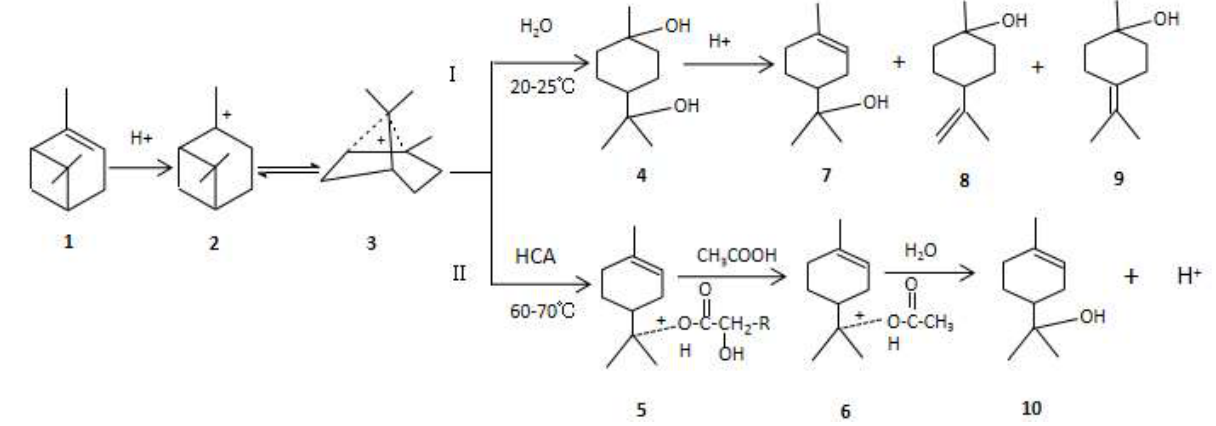
Figure 7. Hydration of α-pinene catalyzed by the HCA–boric acid complex catalyst. 1 : α-Pi- nene; 2 : carbocation; 3 : carbocation; 4 : p -menthane-1,8-diol monohydrate ; 5 : oxonium ion ter- carbocation; 3 : carbocation; 4 : p -menthane-1,8-diol monohydrate; 5 : oxonium ion terpinyl hydrox- pinyl hydroxycarboxylate; 6 : oxonium ion terpinyl acetate; 7 : DL -α-terpineol; 8 : β-terpineol; ycarboxylate; 6 : oxonium ion terpinyl acetate; 7 : DL - α -terpineol; 8 : β -terpineol; 9 : γ -terpineol; 10 : 9 : γ-terpineol; 10 : α-terpineol. α